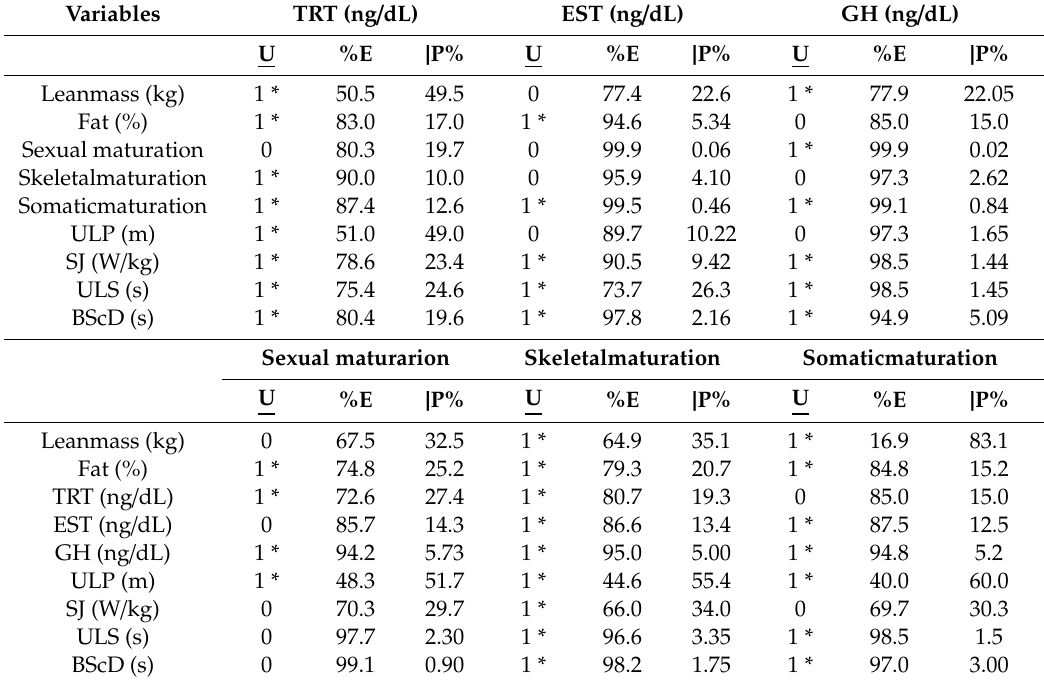
Table 5. Analysis of perceptron neural networks for forecasting possibilities.